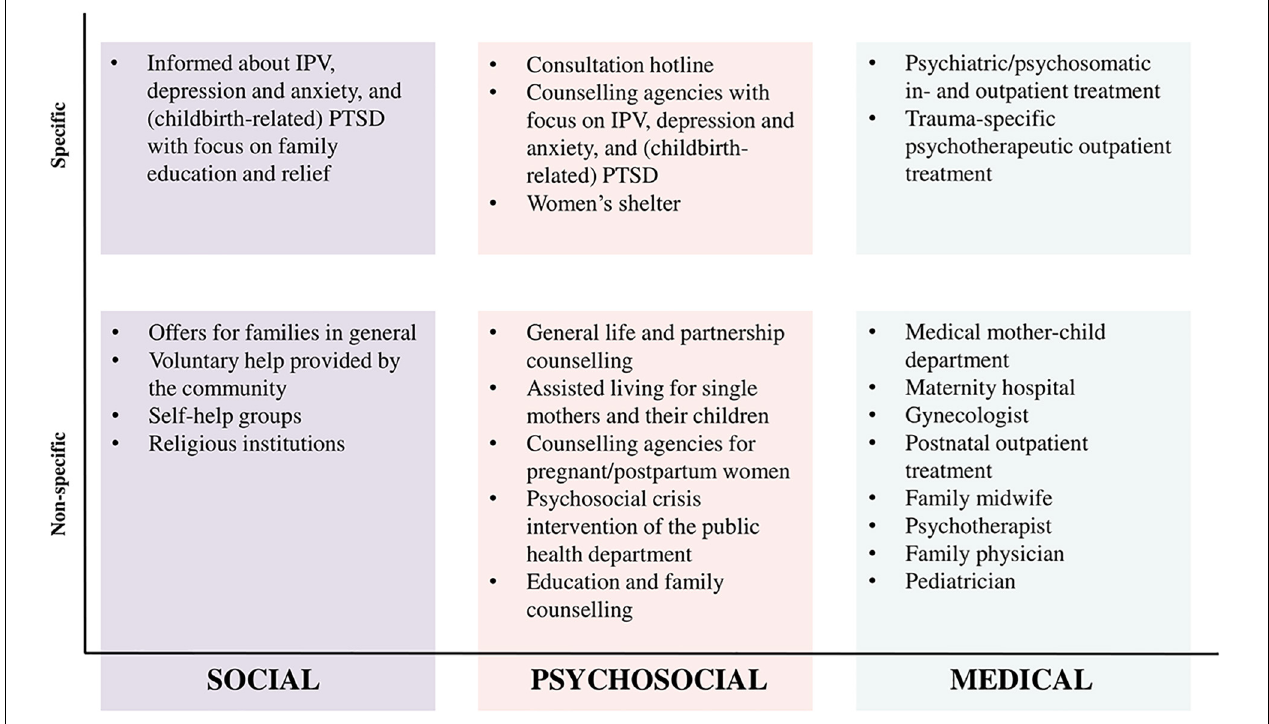
FIGURE 2 | Treatment dimensions of the German support